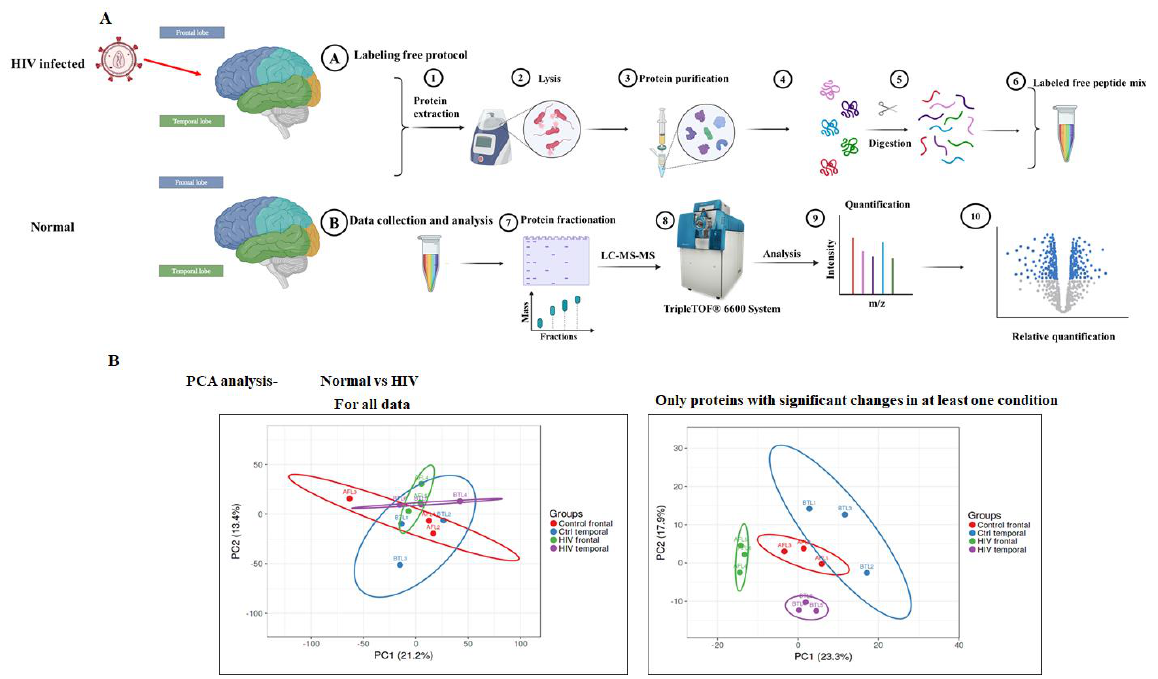
Figure 1. Overview of the sample preparation, analysis, and SWATH-MS analysis of brain tissue samples . ( A ) Study pipeline and proteomic workflow for proteomic analysis of frontal and temporal brain tissues from normal and HIV+ participants for data analysis. ( B ) Principal component analysis (PCA) for all samples performed for all data and only genes with significant changes in at least one condition. Principal component 1 (PC1) and principal component 2 (PC2) were identified by variance in the SWATH-MS Peakview data. The percentage of variance indicates how much variance was explained by PC1 and PC2. (Red: control frontal group; Green: HIV+ frontal group; Blue: control temporal group, violet: HIV+ temporal group).